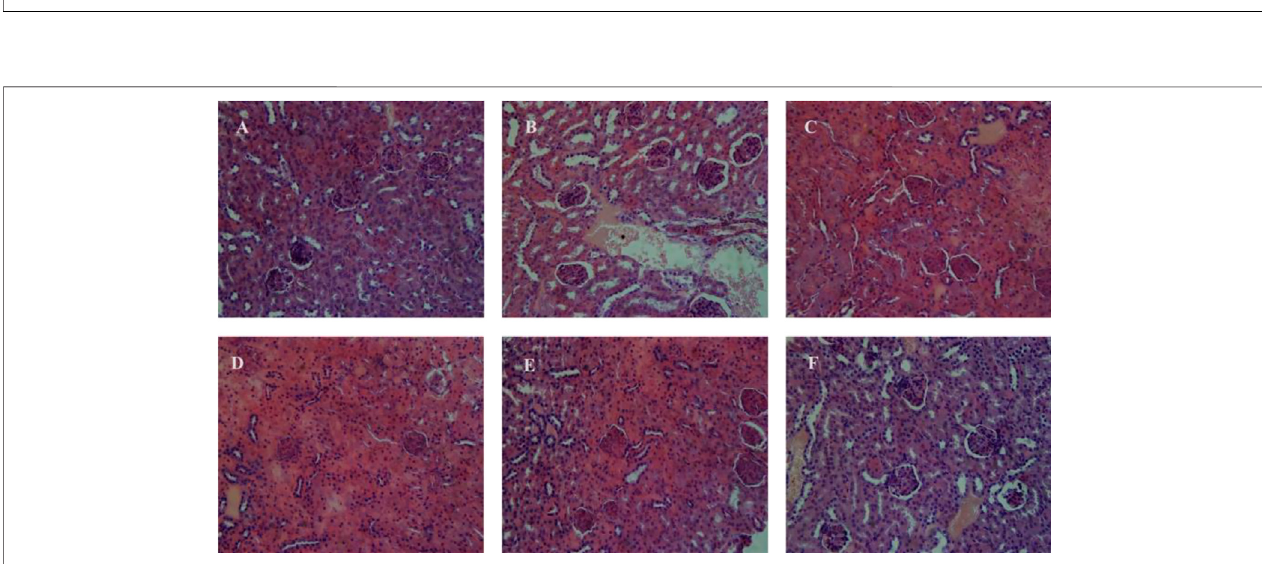
FIGURE 8 | Micrographs express the hepatic (liver) tissues of the mice hematoxylin – eosin (H&E staining; magni fi cations × 400). (A) C +ve, (B) C − ve, (C) L. acidophilus KLDS1.1003only, (D) MRS-basedencapsulated L.acidophilus KLDS1.1003only, (E) L.acidophilus KLDS1.1003pluslead, (F) MRS-basedencapsulated L. acidophilus KLDS 1.1003 plus lead.